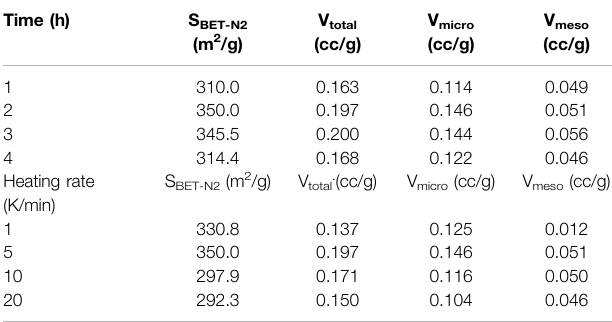
TABLE 2 | Effect of temperature on textural characteristics on bamboo chars. Temp. S BET-N2 (K) (m 2 /g)